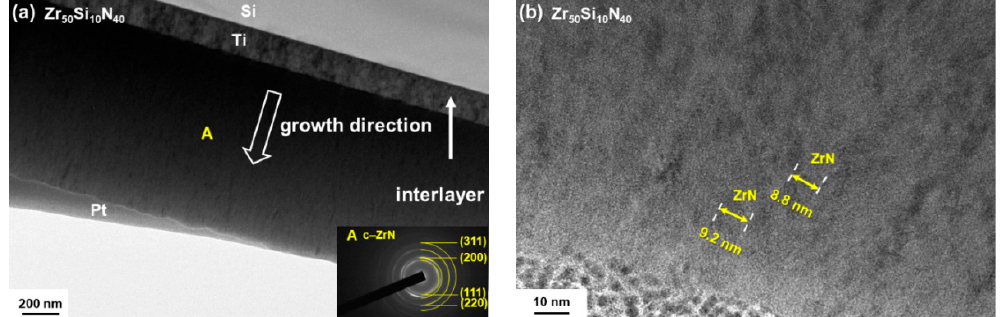
Figure 11. ( a ) Cross ‐ sectional TEM image and SAED pattern and ( b ) high ‐ magnification TEM image of the Zr 50 Si 10 N 40 films.